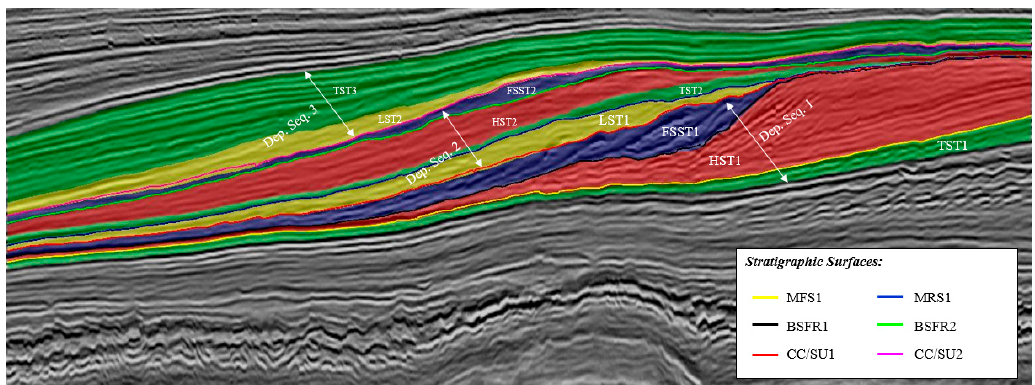
Figure 9. The complete sequence of stratigraphic systems. The three depositional sequence is identified. However, only the two depositional sequence is considered in this study. Table 2. Stratigraphic surfaces with their corresponding events and depositional sequence.